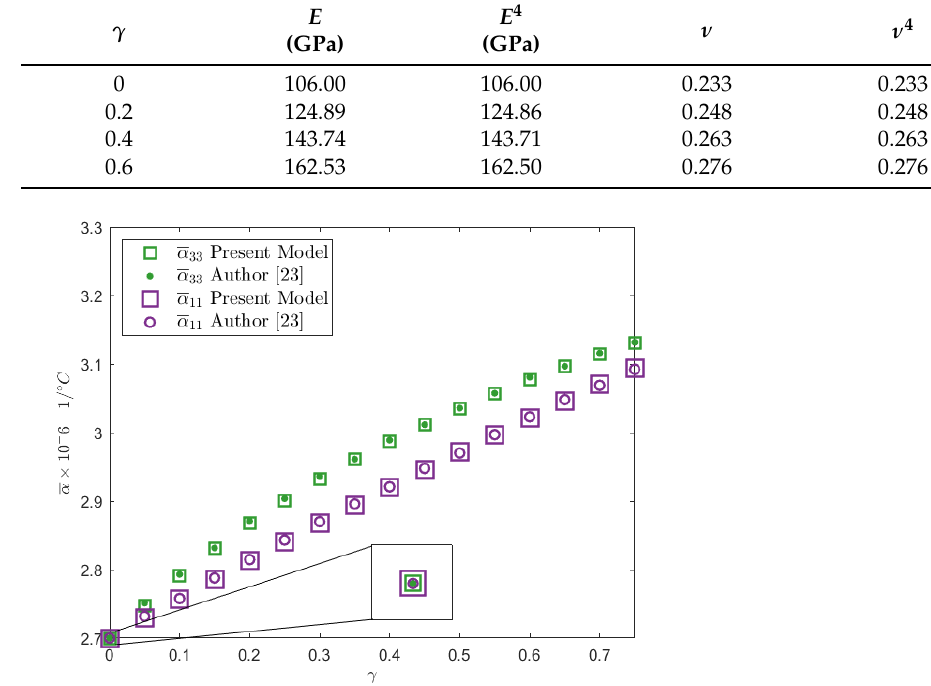
Figure 7. Effective thermal expansion coefficients for the Nicalon/BMAS composite material calcu- lated using the linear FEM, and those reported in ref.